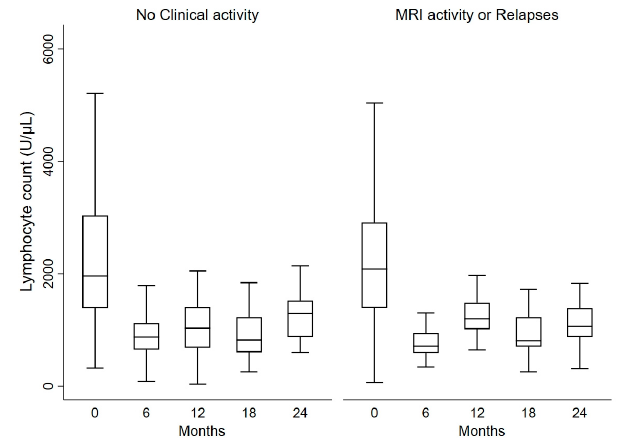
Figure 1. Lymphocyte dynamics in patients with and without clinical or instrumental activity. Clinical activity means the occurrence of disease relapses and instrumental activity means occurrence of gadolinium-enhancing lesions in MRI.